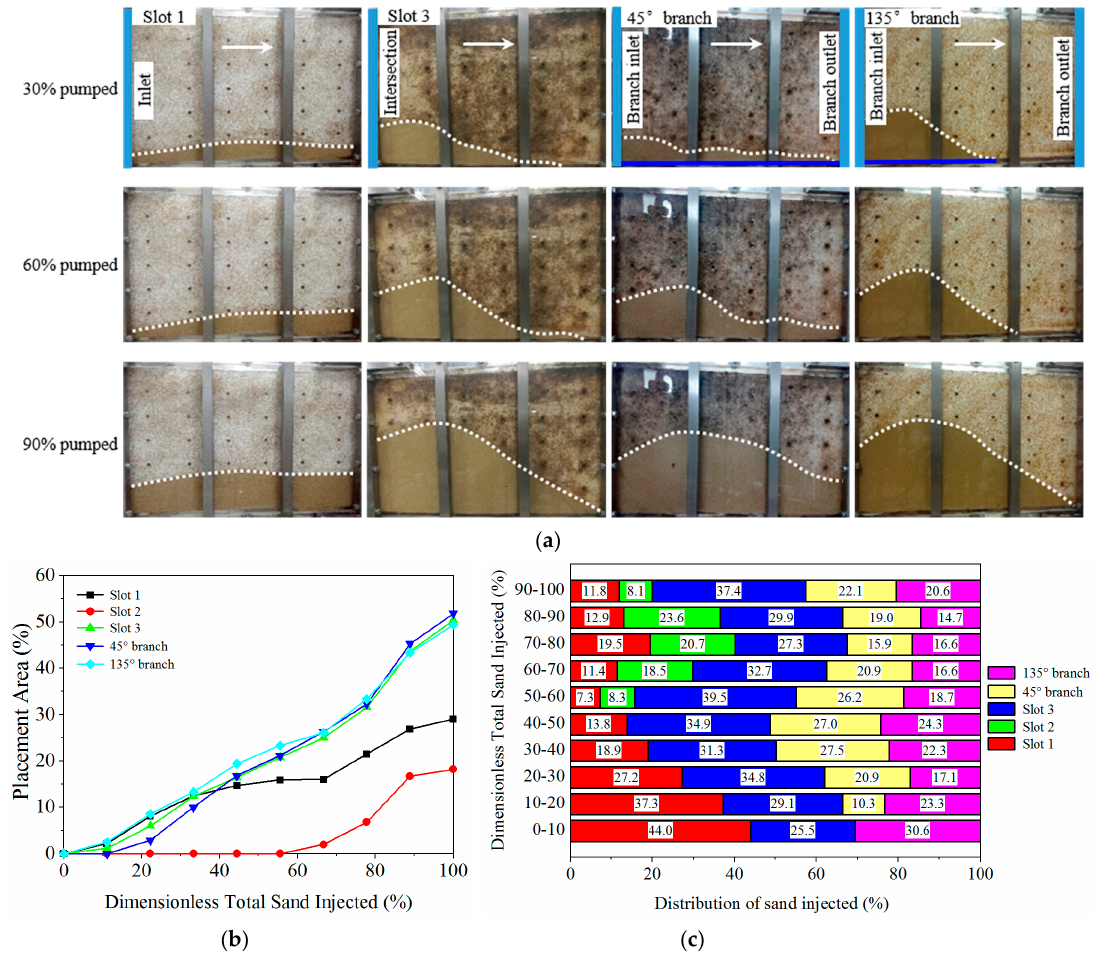
Figure 8. Evolvement of dunes in a slot system with 45°–135°-branches, ( a ) dune geometries in slot 1, slot 3 and branches when 30%, 60%, or 90% of sand were pumped, ( b ) placement areas in the primary and secondary slots, ( c ) distribution of sand injected in the primary and secondary slots.